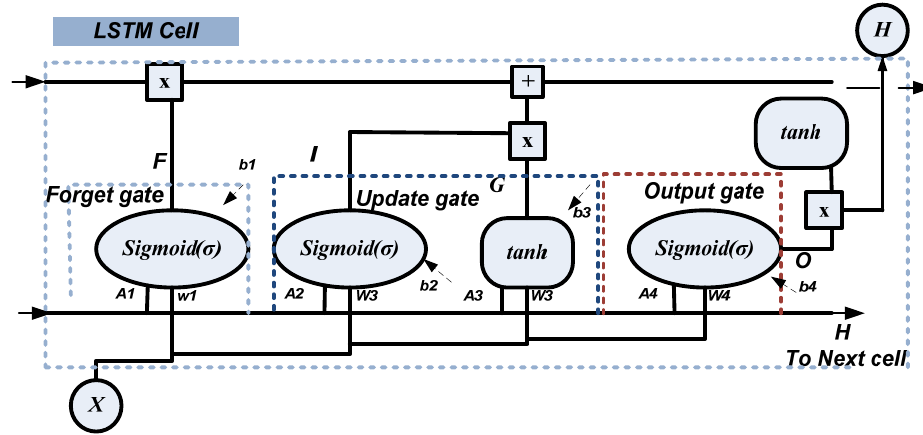
Figure 5. Internal architecture of LSTM cell.